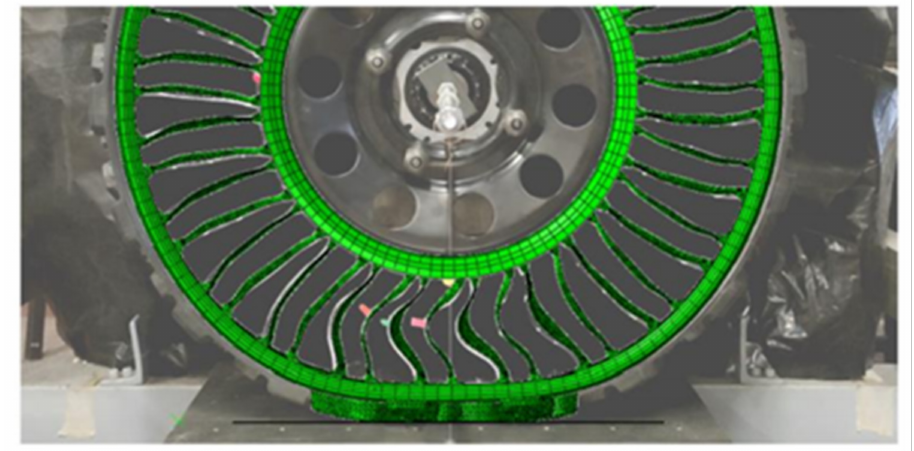
Figure 9. Comparison of the deformed